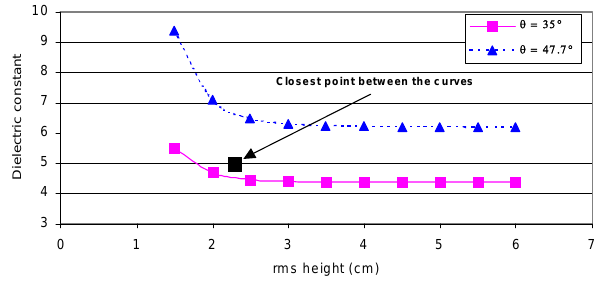
Fig. 10. Variation of the dielectric constant as a function of rms height for two different.